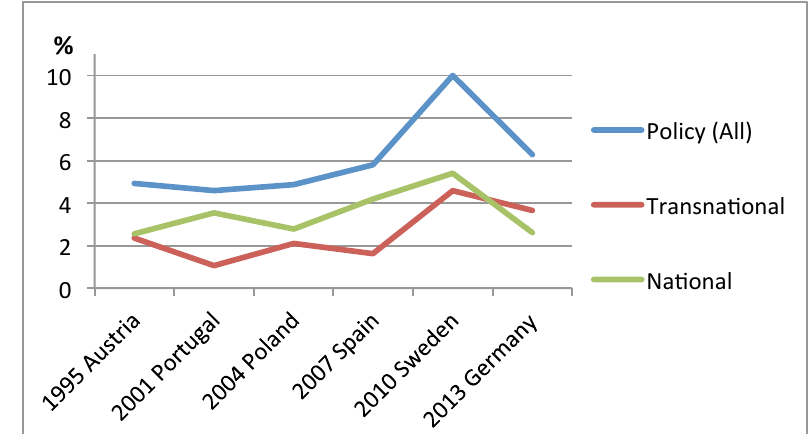
Figure 2: ESREA conferences and the citation rates of different policy documents over time